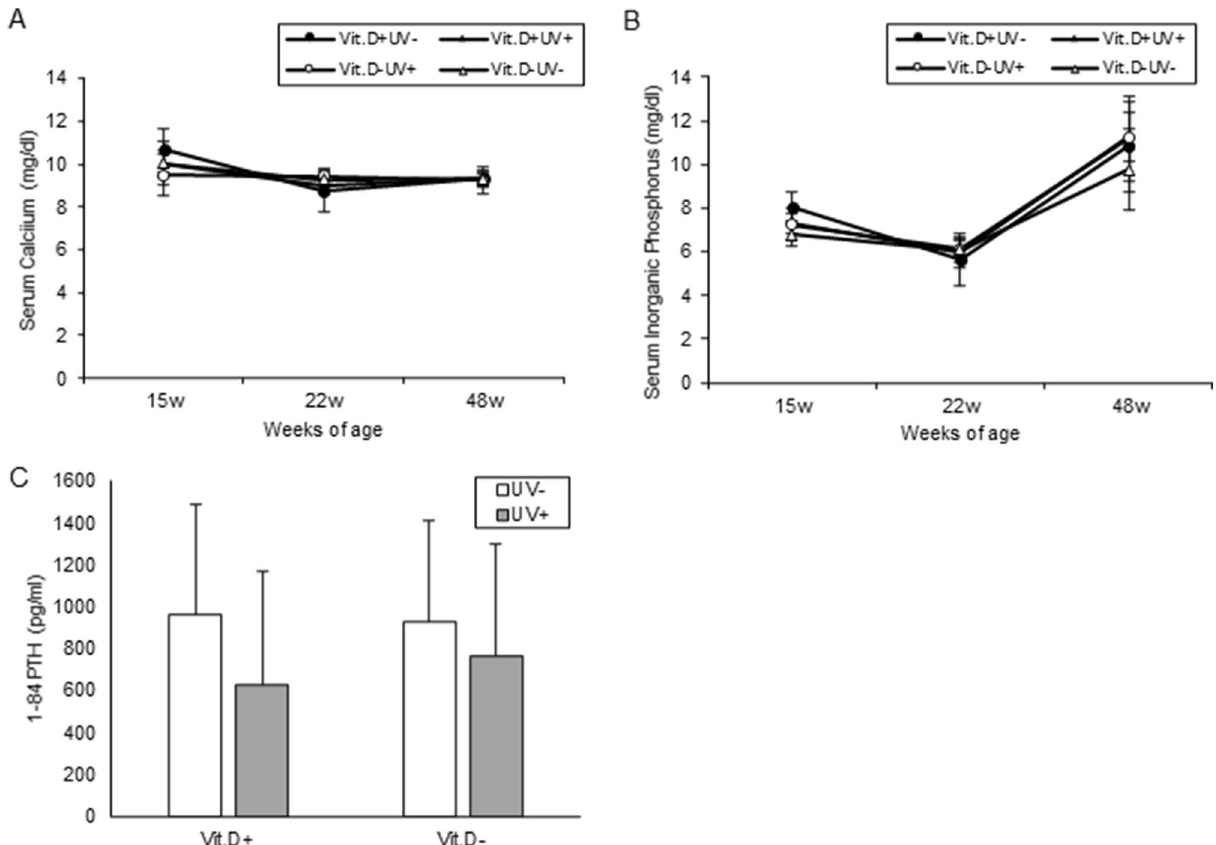
Figure 6. Serum levels of calcium, inorganic phosphorus, and 1–84 PTH. Sera for calcium and inorganic phosphorus determination were collected at 15 weeks of age, 22 weeks, and 48 weeks (24-weeks of UV irradiation). Sera for 1–84 PTH determination were collected at 48 weeks (24-weeks of UV irradiation). ( A ) Calcium. ( B ) Inorganic phosphorus. ( C ) 1–84 PTH. PTH parathyroid hormone; Vit.D − vitamin D-deficient diet; Vit.D + vitamin D-replete diet; UV ultraviolet irradiation.